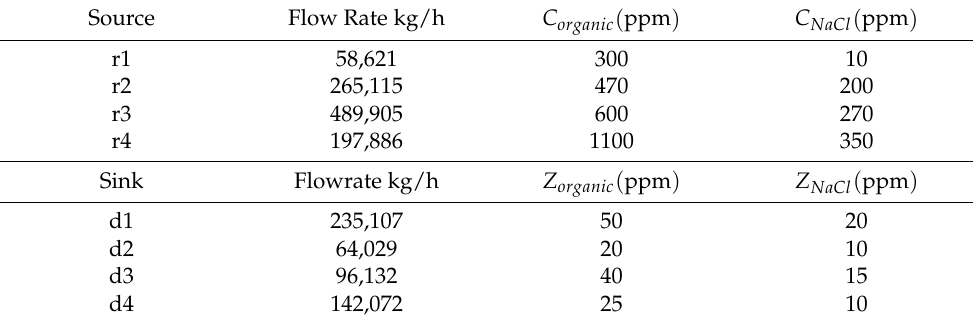
Table 1. Date case study.